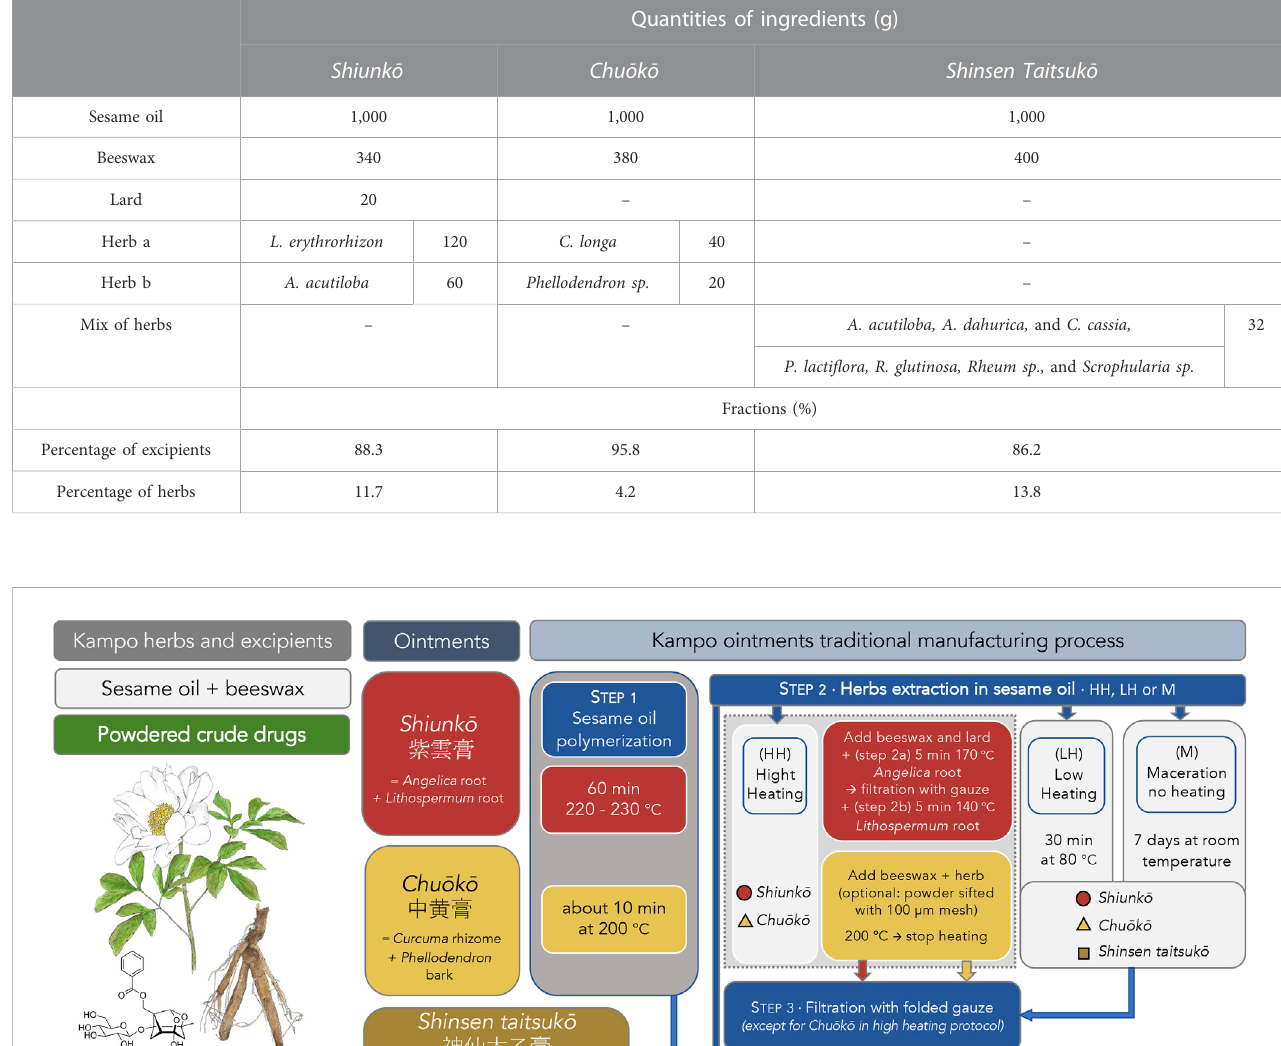
Traditional therapeutic